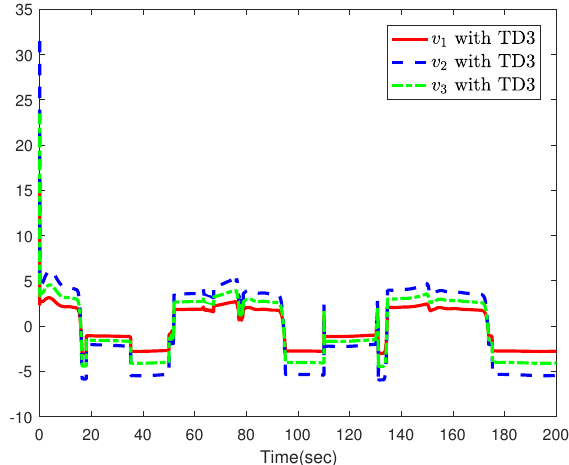
Figure 12. Control effect of System (3) under TD3.